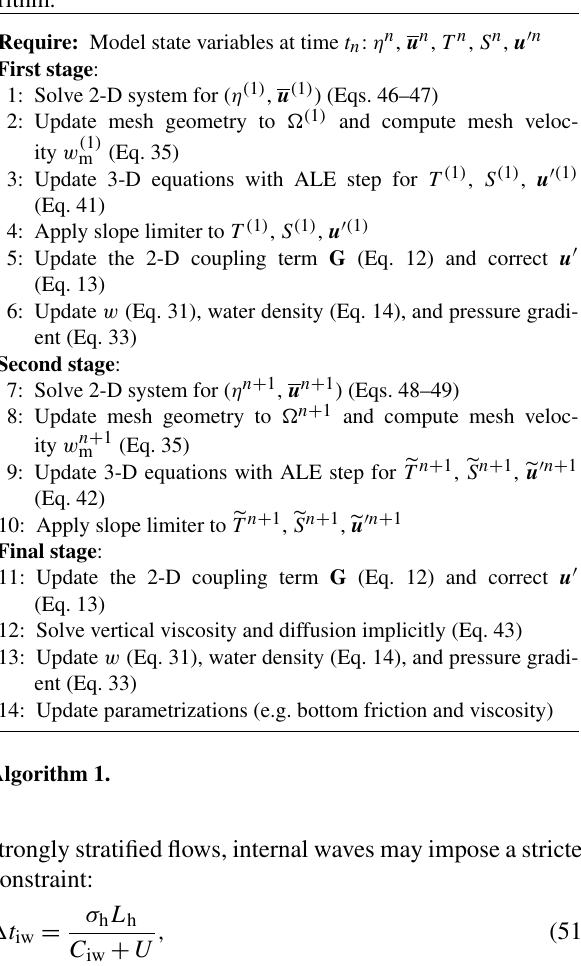
Algorithm 1 Summary of the coupled time integration algo-